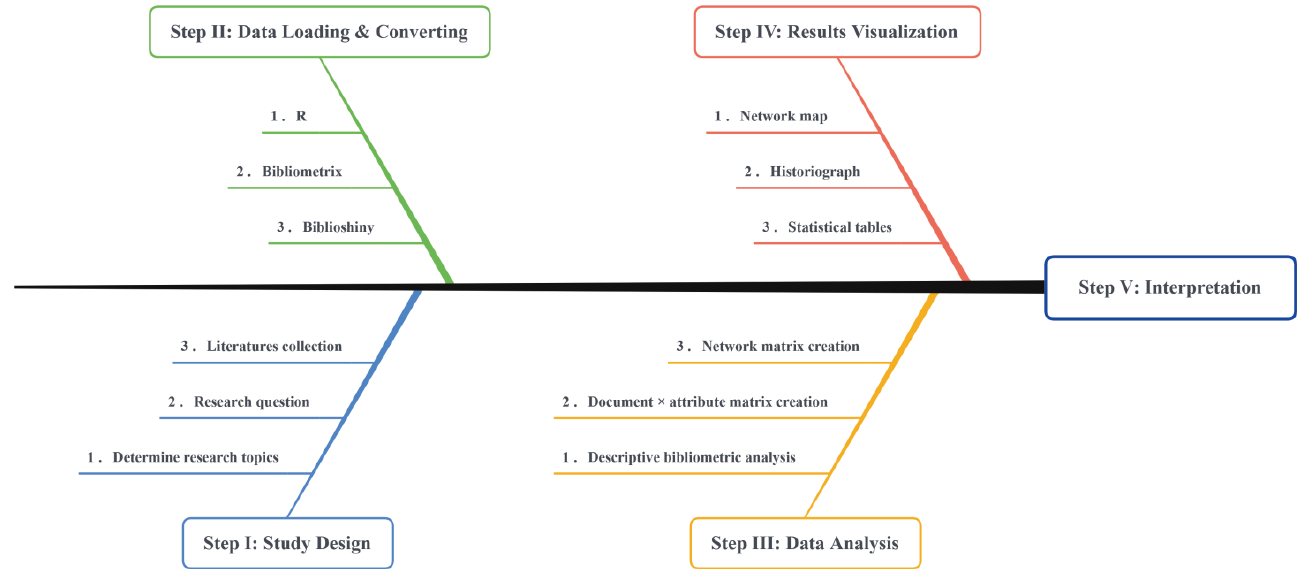
Figure 1. Schematic diagram and main steps of bibliometric analysis method, adapted with per- mission from publications [39,40,81,82]. Copyright 2017, Aria and Cuccurullo; copyright 2019, Firdaus et al.; copyright 2020, Secinaro et al.; and copyright 2022, Xu et